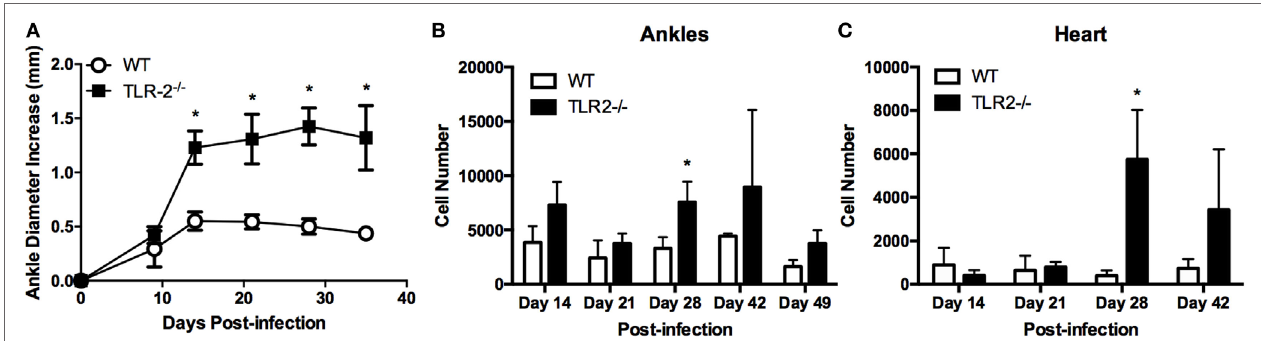
FigUre 1 | arthritis development and T cell infiltrates in Tlr2 − / − mice . (a) Ankle diameters of WT and TLR2 − / − mice were measured weekly following footpad inoculation with 5 × 10 4 B. burgdorferi . At each indicated time point, three mice per strain were sacrificed and numbers of CD3e + T cells were determined from (B) ankles or (c) hearts by flow cytometry. Data are representative of two separate experiments. Symbols represent means ± SD. * p > 0.01 compared to WT control from same time